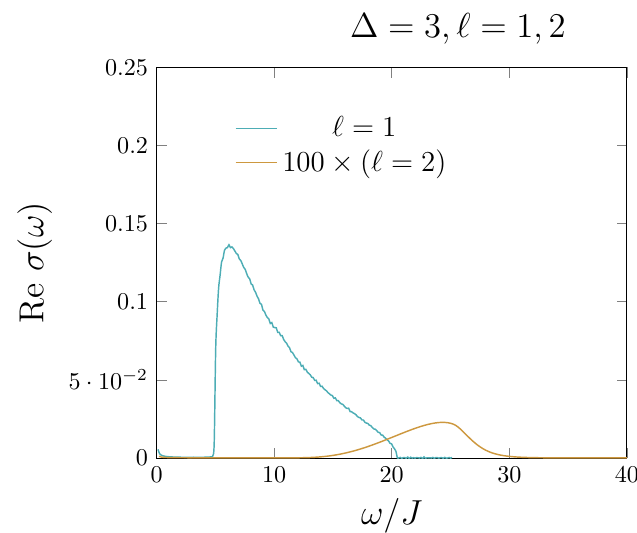
Figure 6: The (cid:96) = 1 and (cid:96) = 2 contributions to Re σ ( ω ) for ∆ = 3. Note that the contribution from (cid:96) = 2 is multiplied by a factor 100. For the Fourier transform for (cid:11) (cid:96) = 2 we use data for (cid:10) J ( t ) J with 0 ≤ m ≤ 39 and 0 ≤ tJ ≤ 30. m + 1 1 Table 2: Both sides of the f -sum rule (32) for ∆ = 1.5,2 and 3 and J = 1. ∆ lhs of (32): (cid:96) = 1 lhs of (32): ( (cid:96) = 1 ) + ( (cid:96) = 2